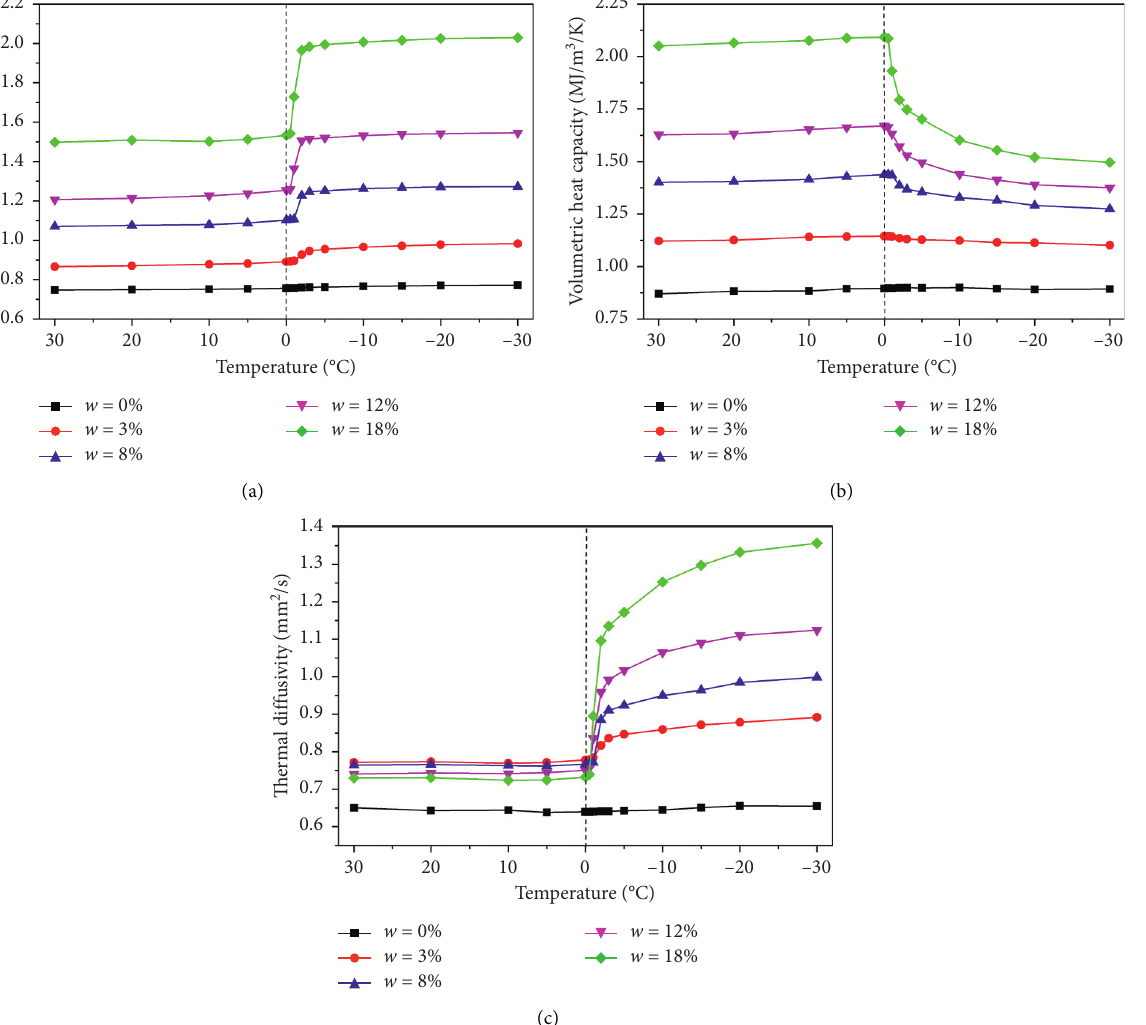
Figure 2: Variations of the thermal properties of loess with the (T) and (w). (a) Thermal conductivity, (b) volumetric heat capacity, and (c) thermal